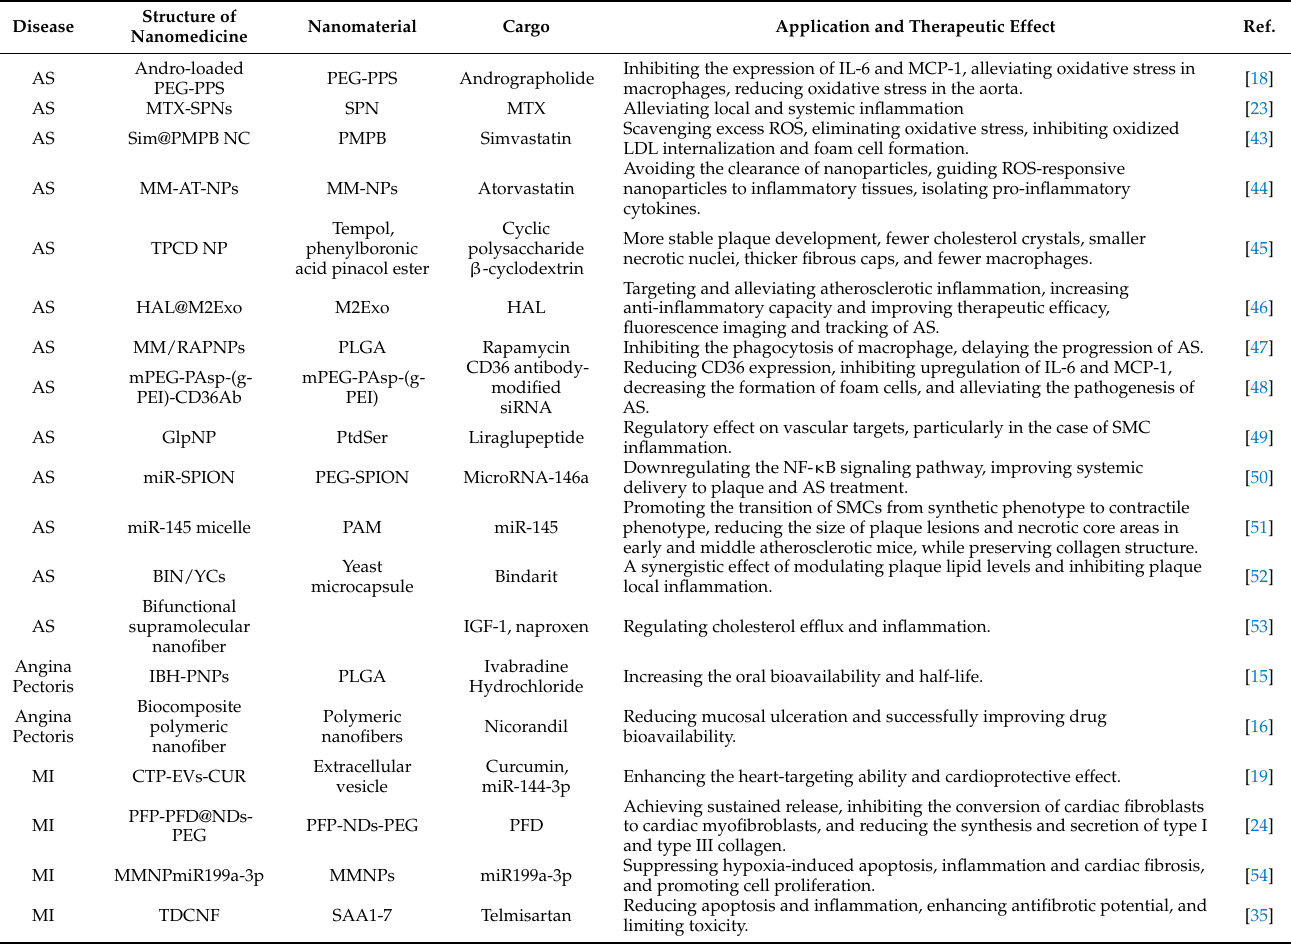
Table 1. Different approaches based on nanoparticles for the treatment of ischemic heart disease. Application and Therapeutic